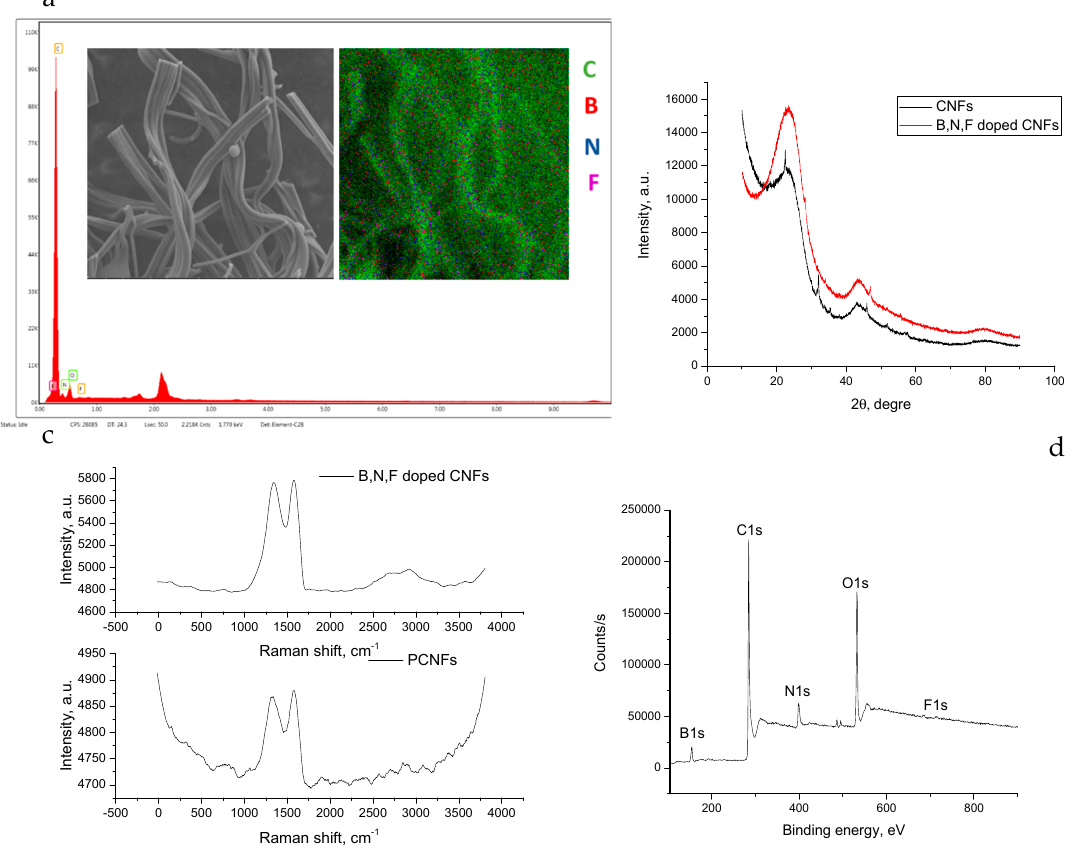
Figure 8. EDX spectra ( a ), XRD pattern ( b ), Raman spectra ( c ), and XPS survey ( d ) results of centrifugally B, N, F-doped CNFs.